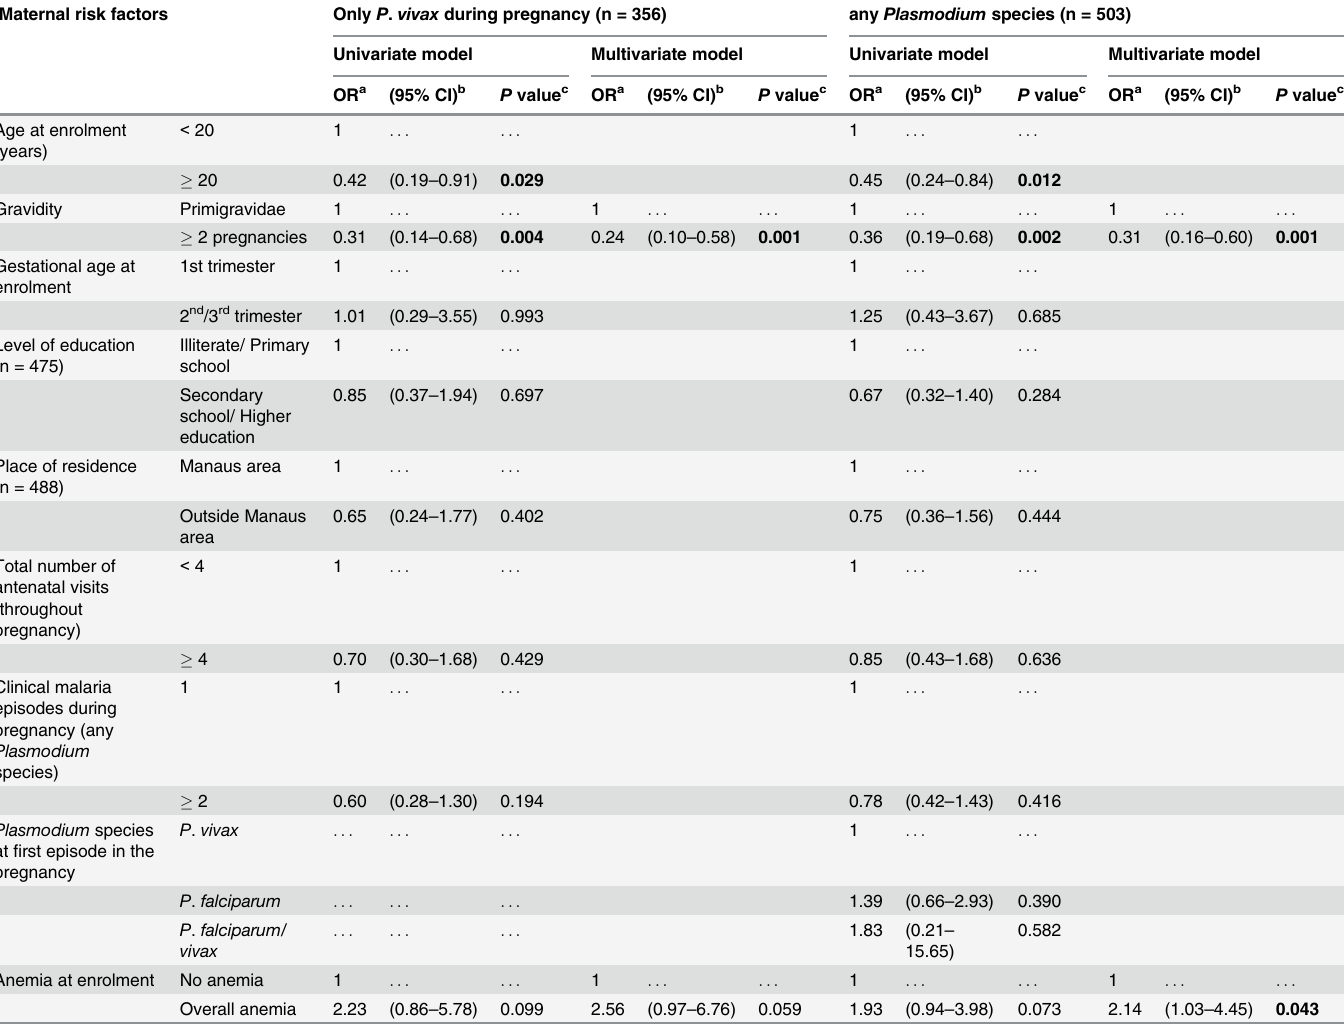
Table 4. Risk factors for low birth weight among study pregnant women with